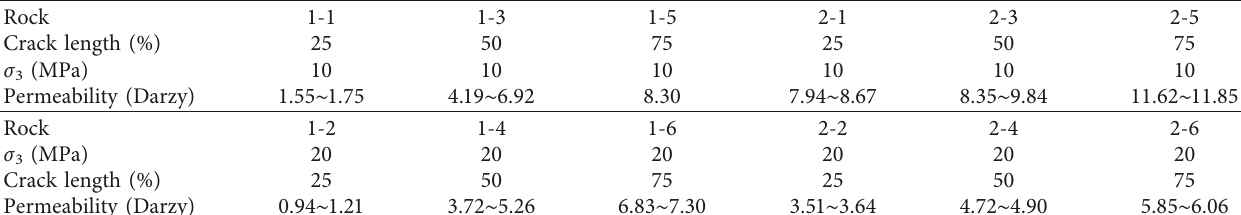
Table 6: Permeability of the filled cracked rocks.